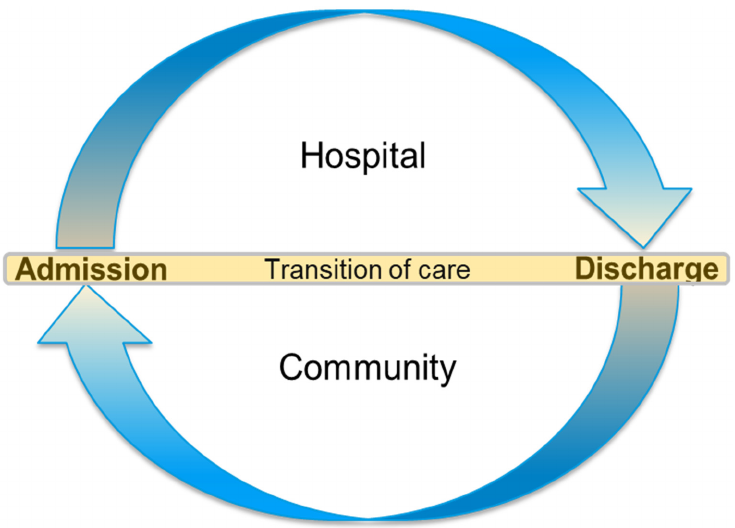
Figure 1. Transition of care from community to hospital and back to community.